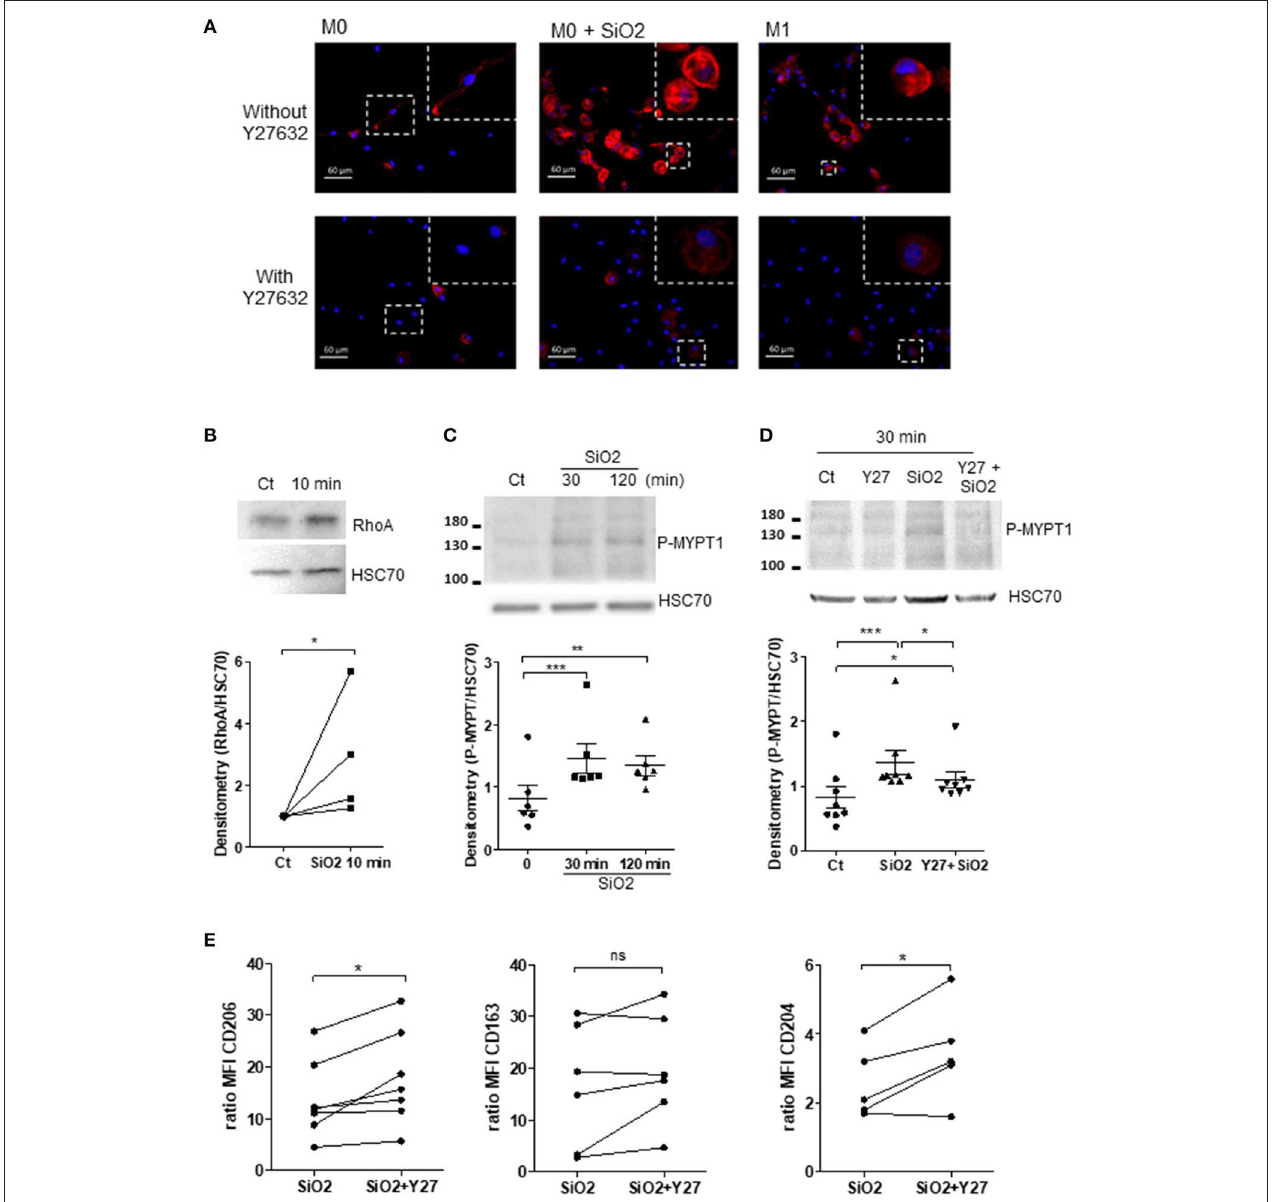
FIGURE 6 | Silica exposure induces cytoskeleton remodeling and alteration of M 8 polarization through activation of the RhoA/ROCK pathway. (A) Representative pictures of fluorescence microscopy: F-actin and nuclei were stained by Alexa Fluor 568-phalloidin (red) and DAPI (blue), respectively. M0-MDM were untreated or treated with 25 µ g/cm 2 of SiO 2 for 10min or polarized into M1 cells for 24h. MDM were also pre-treated or not 1h with the ROCK inhibitor Y27632 at 20 µ M. (B–D) M0-MDM (Ct) from the same healthy donors were pre-treated or not with 20 µ M Y27632 and then untreated or not with 25 µ g/cm 2 of SiO 2 for the indicated time. The GTP-binding fraction of RhoA was pulled-down as described in Materials and Methods. (C,D) Western-blot analyzes of Phospho-MYPT1 expression were performed on whole-cell lysates. The relative levels of the proteins were determined by densitometry (Experiment on MDM from 4 to 8 different healthy donors). (E) Effect of Y27632 on the membrane expression of CD206, CD163, and CD204. MDM from the same healthy donors were pre-treated or not 1h with the ROCK inhibitor Y27632 at 20 µ M before exposure to 25 µ g/cm 2 of SiO 2 for 4h; data determined by flow cytometry are expressed as ratio of MFI (Experiment on MDM from 5 to 7 different healthy donors). * p < 0.05; ** p < 0.01; *** p < 0.001; ns, not